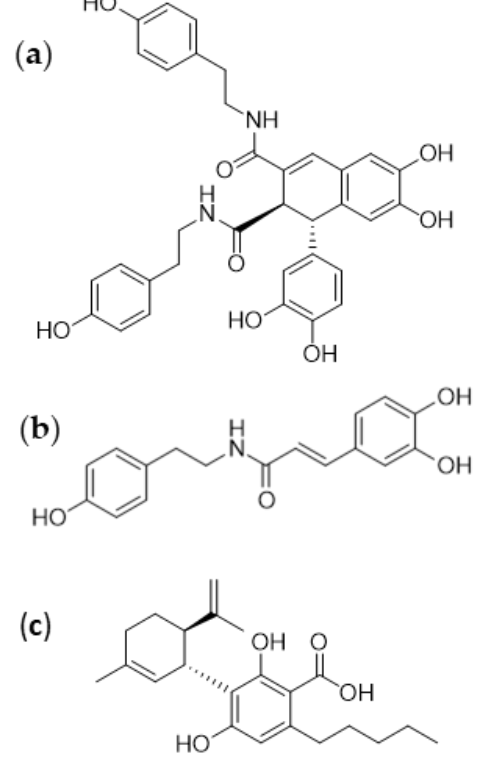
Figure 1. Chemical structures of the three metabolites isolated from hemp seeds. Cannabisin B ( a ), N - trans -caffeoyltyramine ( b ), and cannabidiolic acid ( c ) were isolated from Cannabis sativa seeds.